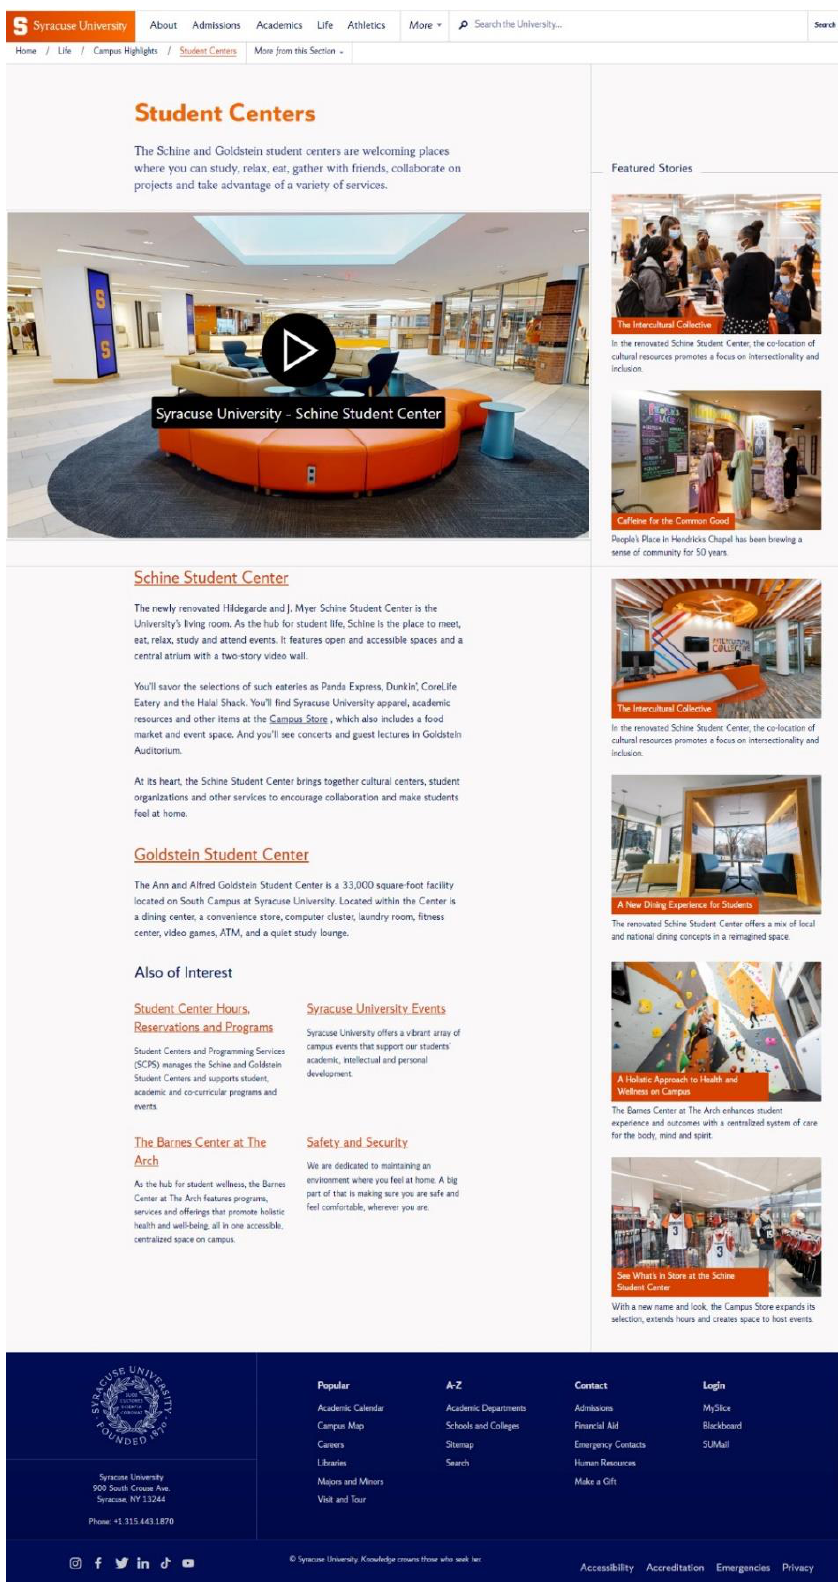
Figure A1. The web page of high aesthetic quality (Syracuse State University).